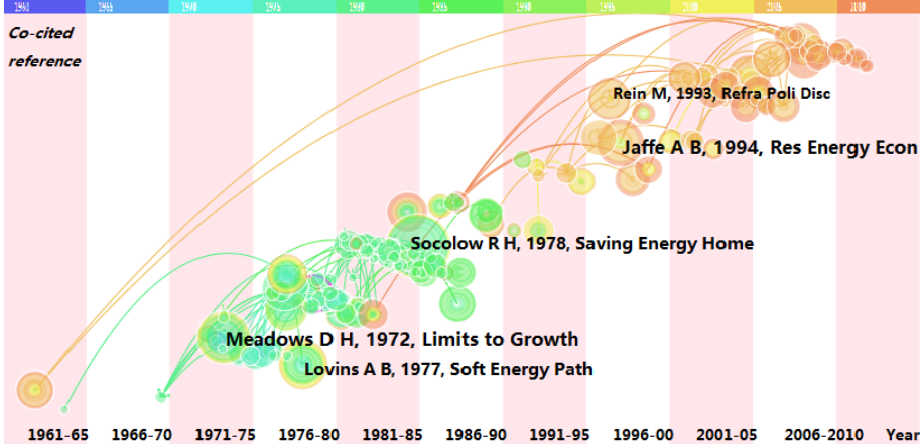
Figure 3. Time period view of the co ‐ citation network.